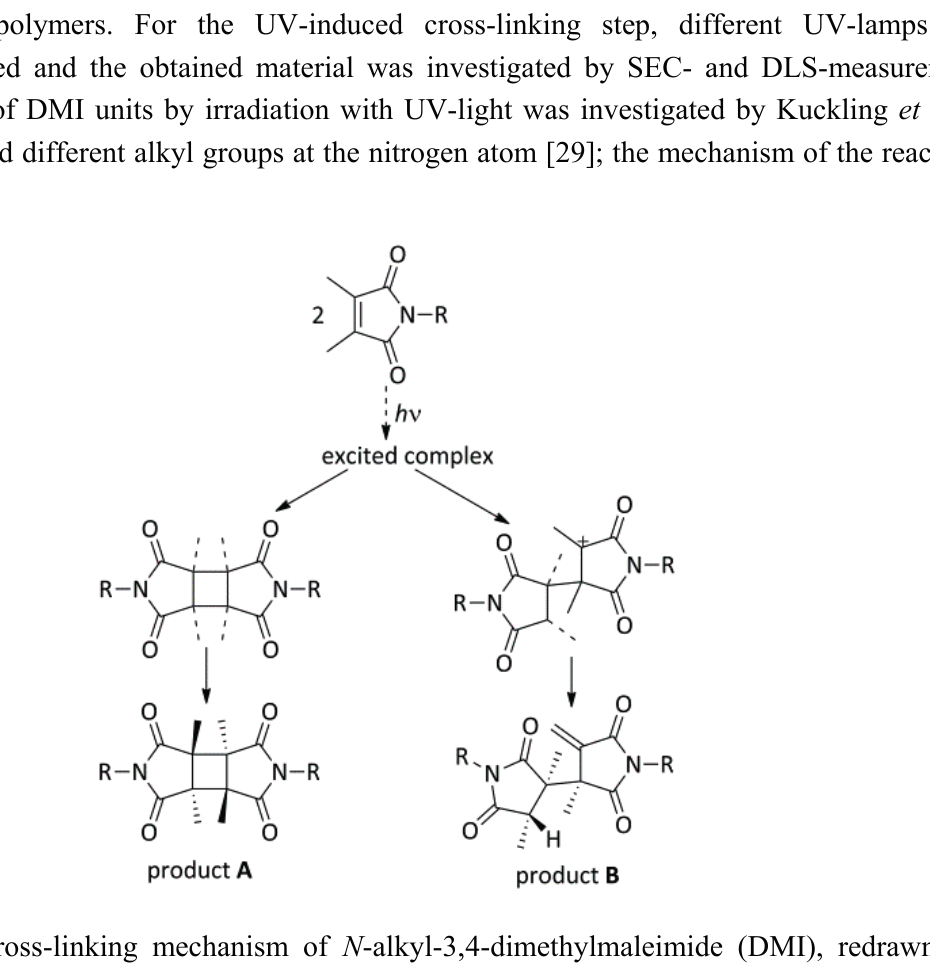
Figure 7. Cross-linking mechanism of N -alkyl-3,4-dimethylmaleimide (DMI), redrawn from reference